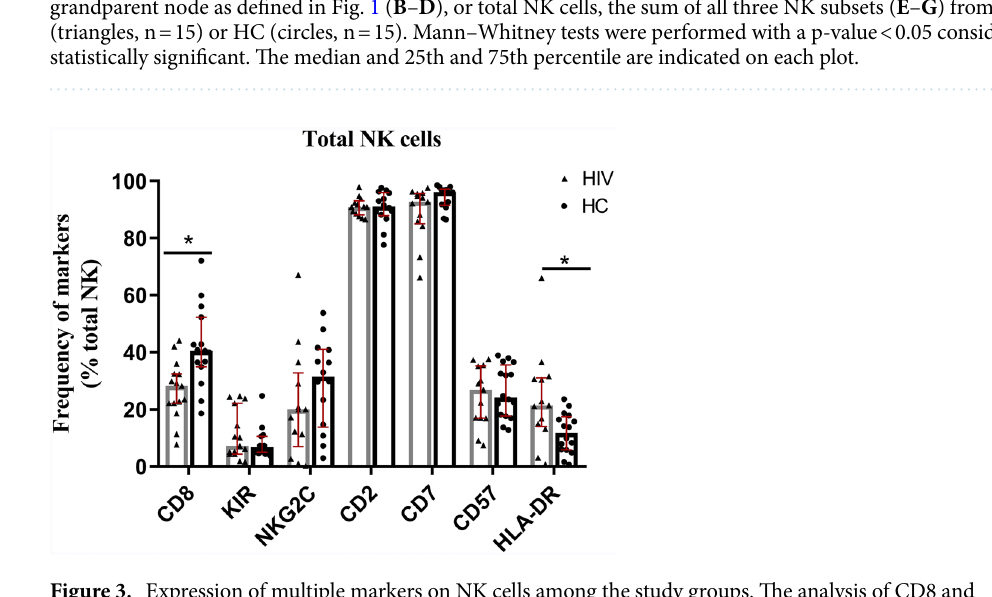
Figure 3. Expression of multiple markers on NK cells among the study groups. The analysis of CD8 and KIR3DL1/S1 expression was quantified on total NK cells comprising CD56 bright CD16 − , CD56 dim CD16 bright , and CD56 − ve CD16 bright , whereas the expression of NKG2C, CD2, CD7, CD57, and HLA-DR were determined from NK cells comprising the CD56 bright and CD56 dim subsets. A total of 15 subjects were evaluated for HIV and 15 for HC subjects for CD8 and KIR markers; 13 (HIV) and 14 (HC) subjects for NKG2C, CD2, CD7; and 13 (HIV) and 16 (HC) subjects for CD57 and HLA-DR marker expression. Abbreviations on X-axis refer to the different NK cell markers. Mann–Whitney tests were performed with a p-value < 0.05 considered statistically significant. The median and 25th and 75th percentile are indicated on each